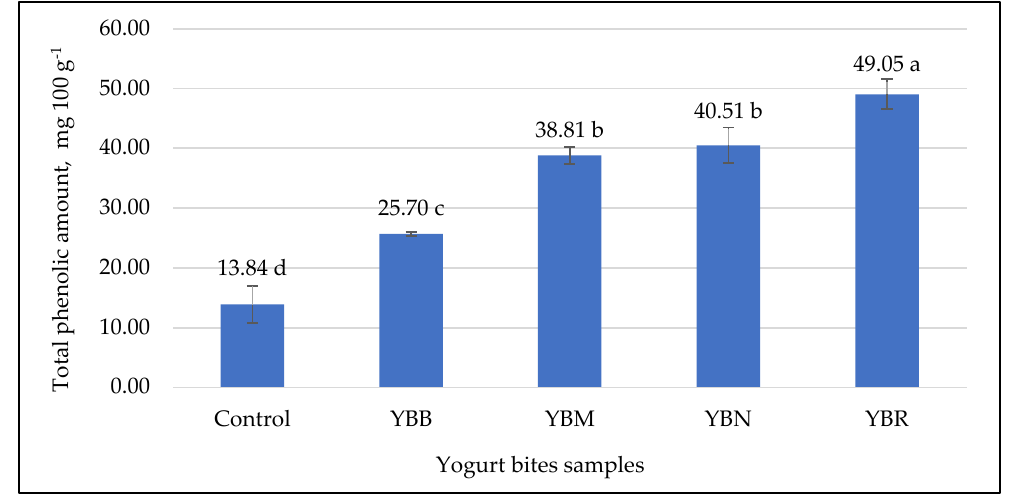
Figure 2. Total phenolic content of yogurt bites, mg · 100 g − 1 . Different letters represent significant differences between samples ( p < 0.05). Control—yogurt bites without plant raw materials, YBB—yogurt bites with 1% beetroot powder, YBM—yogurt bites with 1% mulberry leaves powder, YBN—yogurt bites with 1% nettle leaves powder, YBR—yogurt bites with 1% rosehip fruit powder.